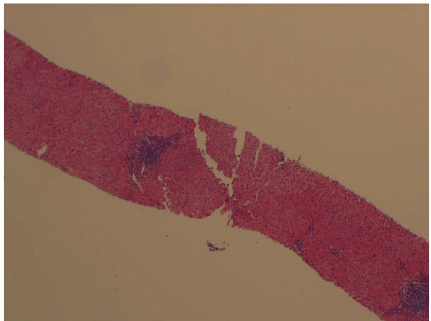
Figure 1: Liver biopsy showing grade 2 inflammation activity and stage 1 fibrosis.